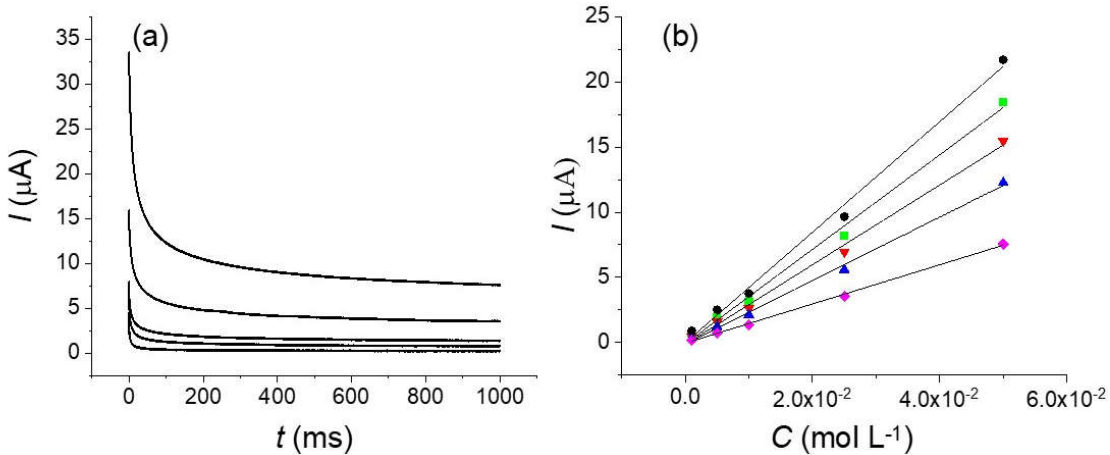
Figure 9. ( a ) Chronoamperogram obtained for different concentrations of potassium ferrocyanide from top to bottom: 5 × 10 −2 , 2.5 × 10 −2 , 1 × 10 −2 , 5 × 10 −3 and 1 × 10 −3 mol L −1 . ( b ) Current vs. concentration at different measurement times 10 (black) , 20 (green), 40 (red), 100 (blue), 1000 (pink) ms. Applied potential 0.65